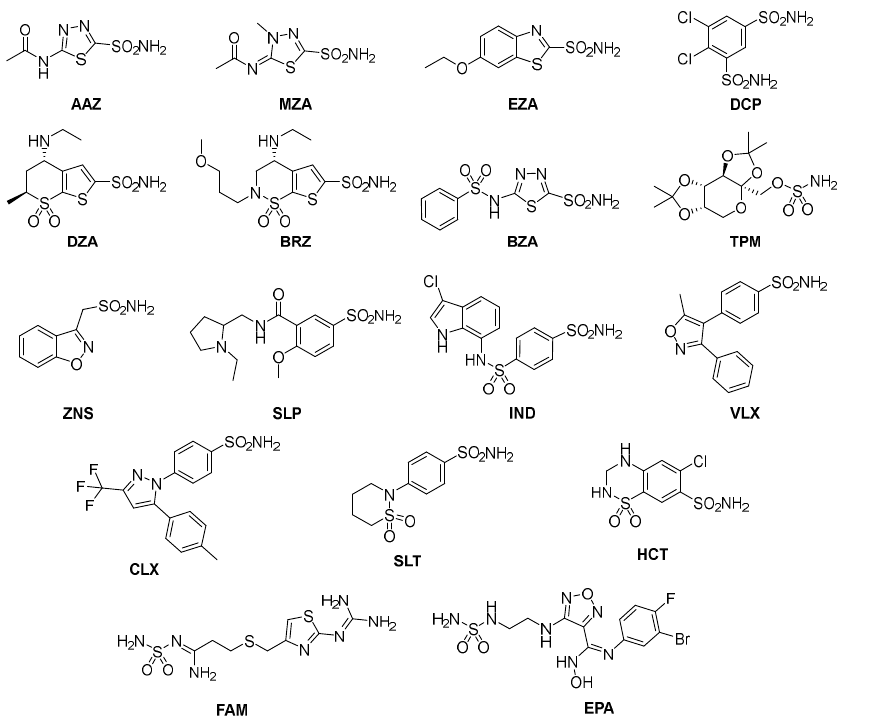
Figure 4. Structure of commercially available sulfonamide derivatives 1–24 .